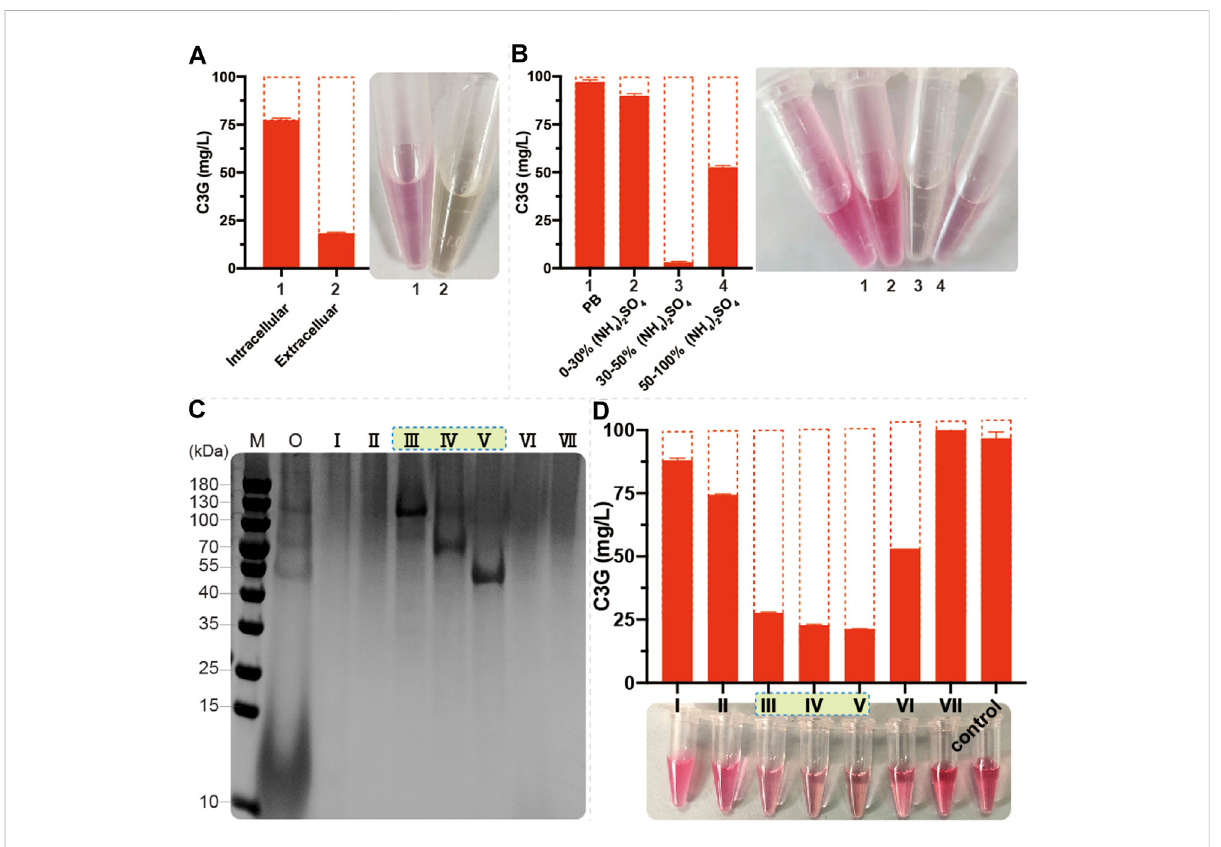
FIGURE 4 Identi fi cation of endogenous anthocyanin-degrading enzymes (A) 1 ml of fermentation broth (with YPD medium) of CENPK2-1D was centrifuged at 6000g and 30 ° C for 1 min; the supernatant was extracellular proteins. The cell pellet was washed twice with 2 ml of 20 mmol/L PB (pH = 5.0, 4 ° C). The intracellular proteins were obtained by cell disruption with 1 ml of 20 mm PB and 0.1-mm glass beads in FastPrep-24 5 G . Then, 100 mg/L C3G was added to extracellular and intracellular proteins at 220 rpm and 30 ° C for 12-h incubation. An equal volume of acidi fi ed methanol as the chromogenic reagent was added to the sample (B) Then, 0% – 30%, 30% – 50%, and 50 – 100% protein components were obtained during ammonium sulfate precipitation; 100 mg/L C3G was added for 12-h incubation at 220 rpm and 30 ° C. An equal volume of acidi fi ed methanol as the chromogenic reagent was added to the sample (C) M: marker; O: 30 – 50% protein component; Ⅰ – Ⅶ : seven elution signal peaks (D) 100 mg/L C3G was added to Ⅰ – Ⅶ for 12-h incubation at 220 rpm and 30 ° C. An equal volume of acidi fi ed methanol as the chromogenic reagent was added to the sample.